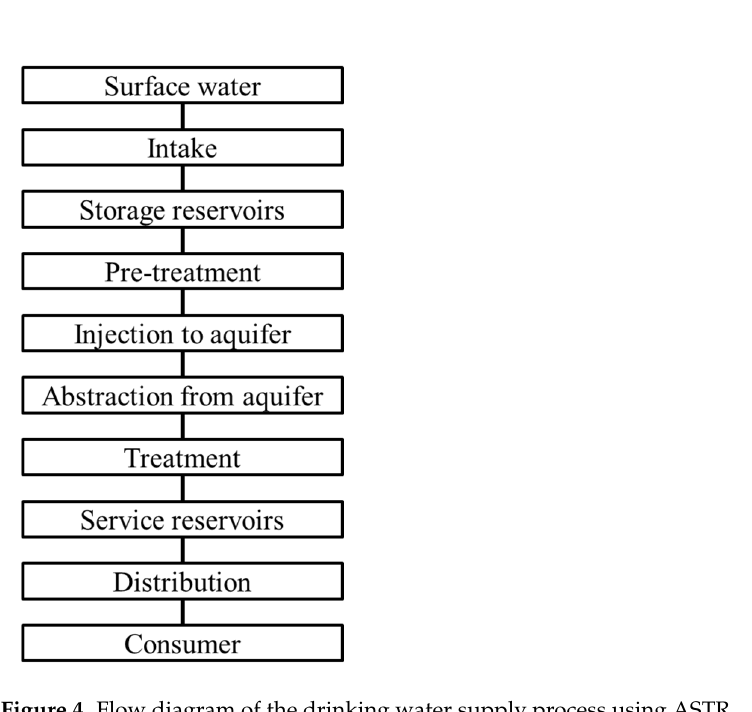
Figure 4. Flow diagram of the drinking water supply process using ASTR.